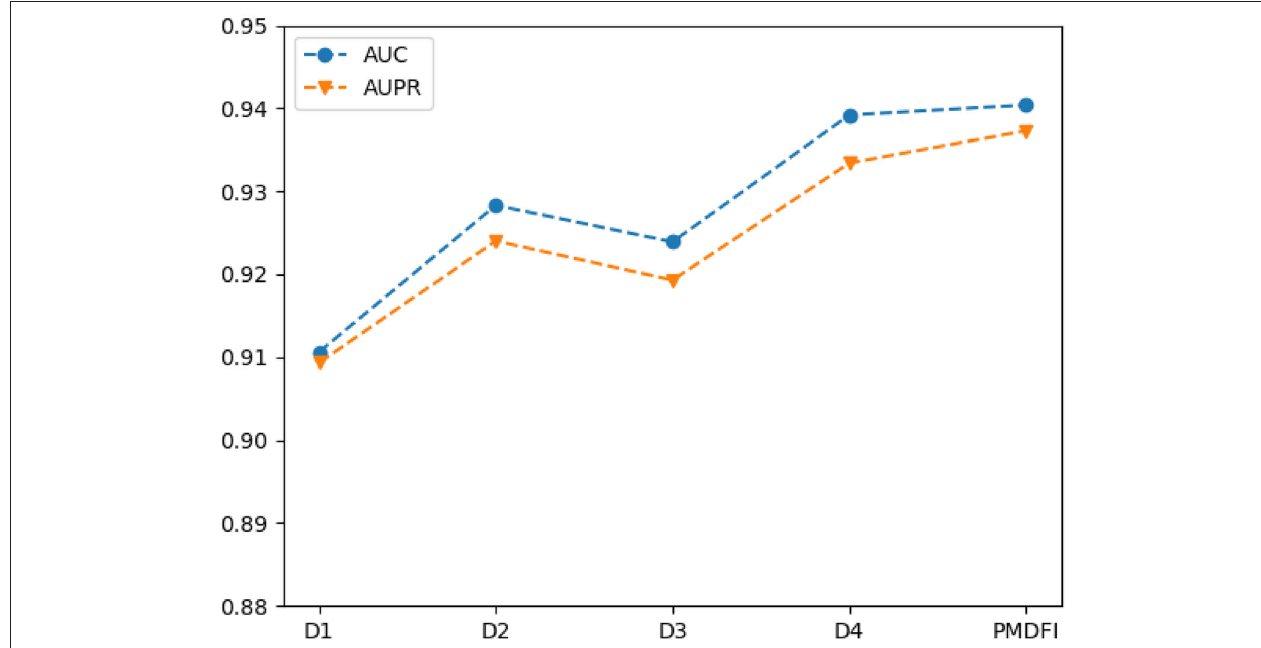
FIGURE 4 | Line chart of area under the ROC curve (AUC) and area under the PR curve (AUPR) scores of different interaction cross features.